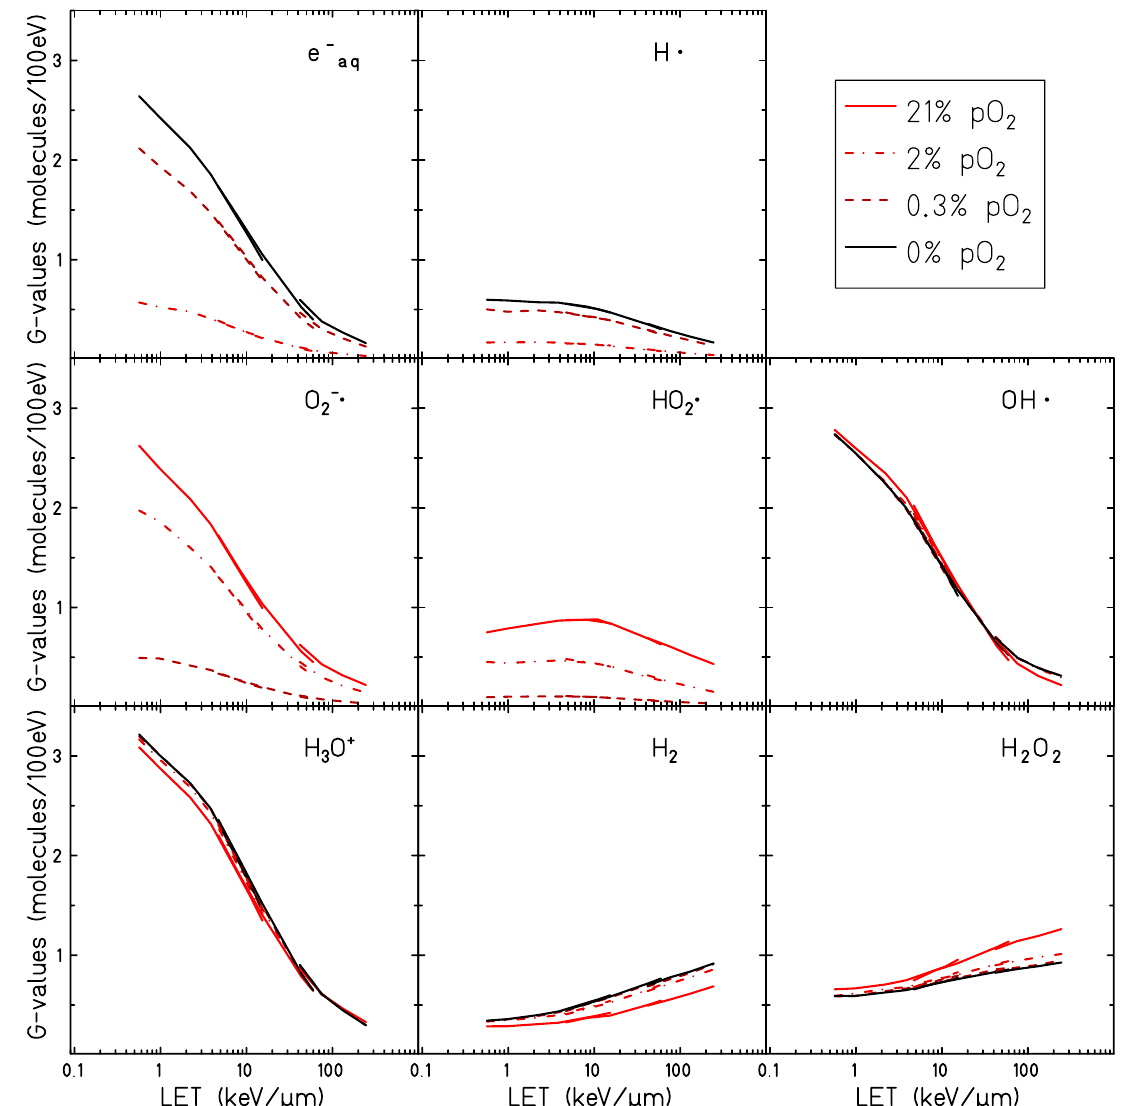
Figure 6. LET dependent radiolytic yields for all chemical species generated by the water radiolysis in water target at a partial oxygen pressure of 0%, 0.3%, 2% and 21%. Calculations were performed with protons, helium ions and carbon ions at one microsecond after the